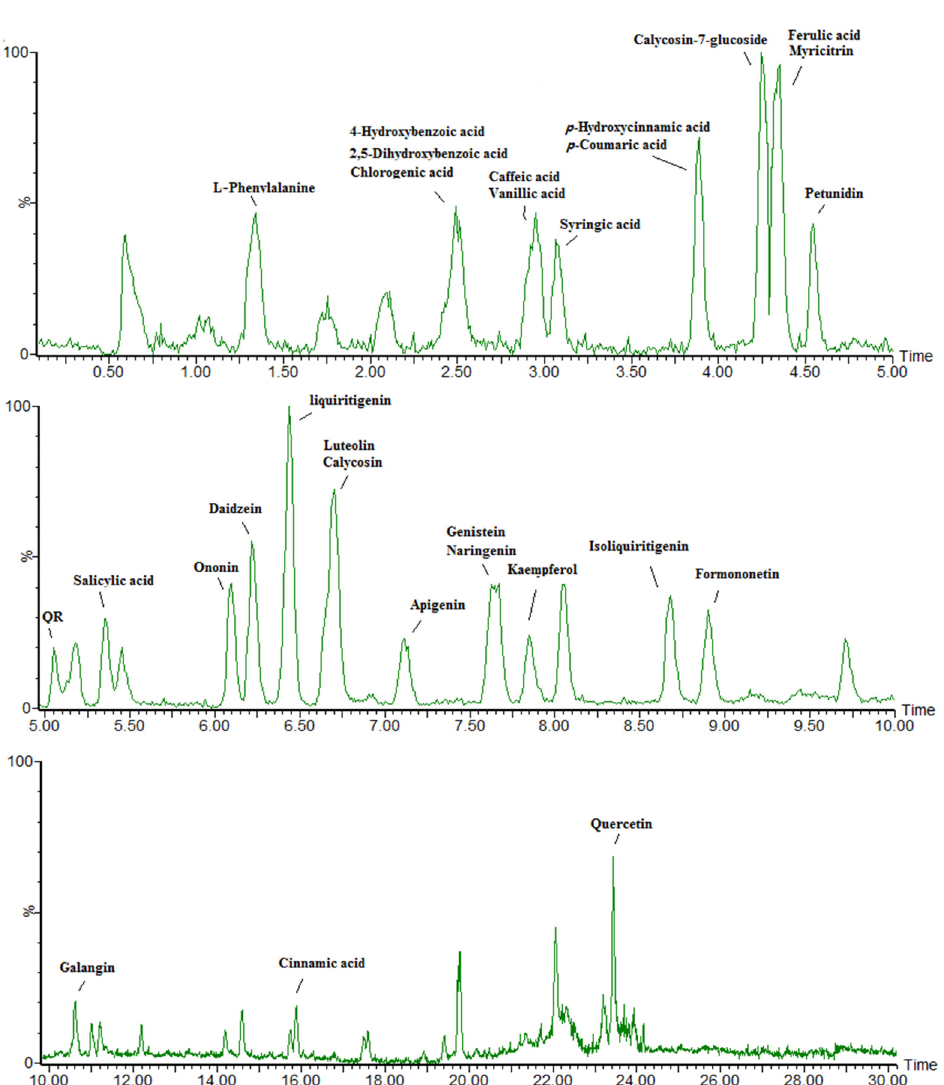
Figure 2. Chromatogram of the target compounds from ultra-performance liquid chromatography quadrupole time-of-flight mass spectrometry (UPLC-TOF-MS). Targeted compounds in samples were determined in accordance with the mass spectral information and retention time of the corresponding standard reference compounds. QR: Quercetin-3- O -rhamnoside.